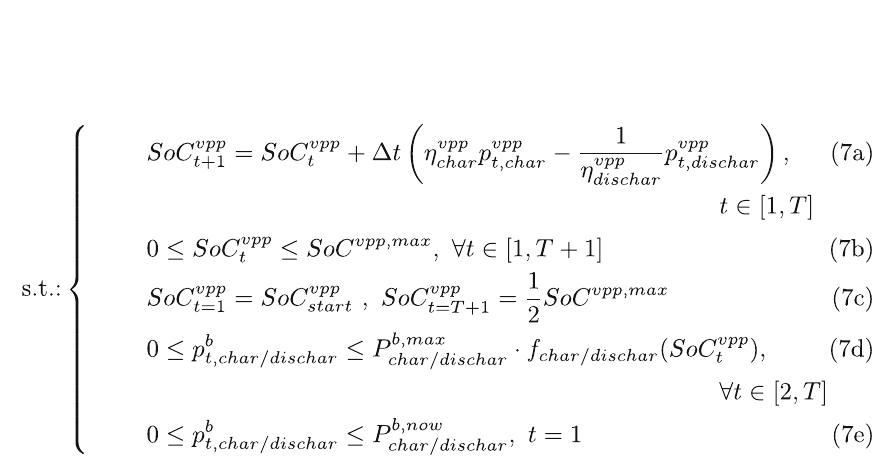
As noted before, for the function f char / dischar , different models can be meaningful. Later on tested are linear, concave and non-concave piece-wise linear functions. Therefore, in contrast to the optimization problem (1), the model (7) may become a mixed-integer lin- ear program. However note, that the problem is much smaller with having only one set of variables for the single VPP instead of for each BESS b ∈ { 1, . . . , n bess }